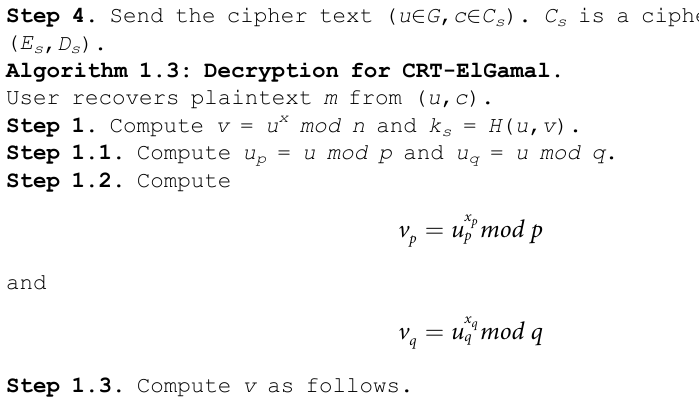
Algorithm 1.3: Decryption for CRT-ElGamal